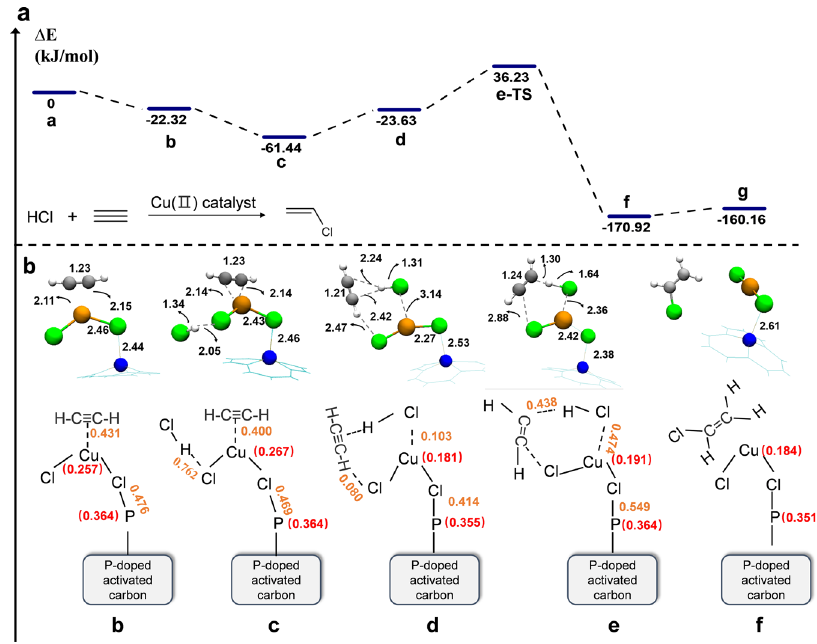
Fig. 7 DFT calculations on the reaction mechanism. a Energy pro fi le of acetylene hydrochlorination of HCl and C 2 H 2 , b Optimized geometries of intermediates and transition states. Numbers are distances (Å) between atoms, numbers in red are Hirshfeld charges, and numbers in brown are Mayer bond